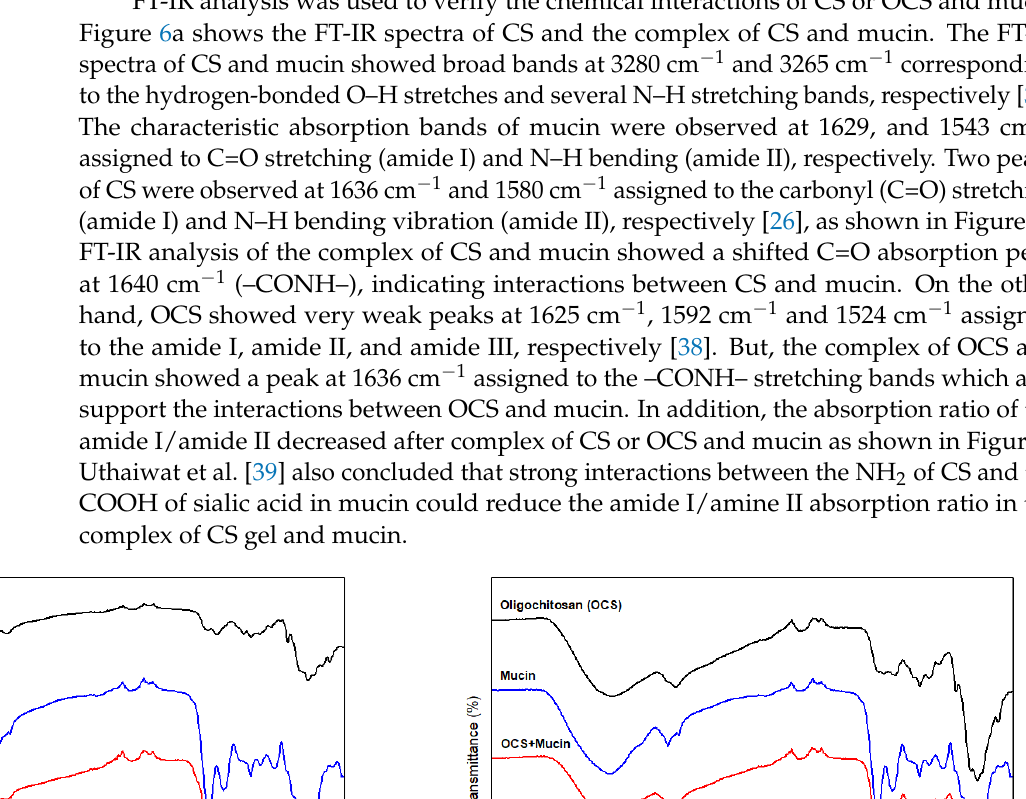
Figure 5. Circular dichroism spectra of CS, mucin, and CS + mucin ( a ) and OCS, mucin, and OCS + mucin ( b ).